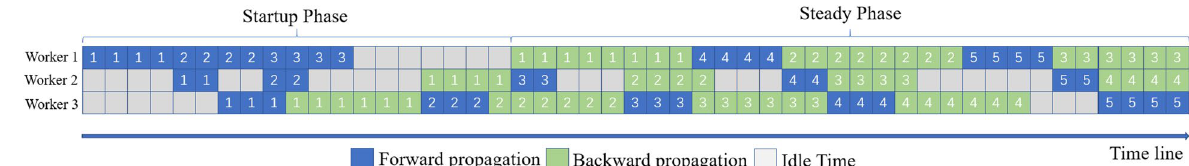
Fig. 5 An example of traditional layer-wise partition with 1F1B